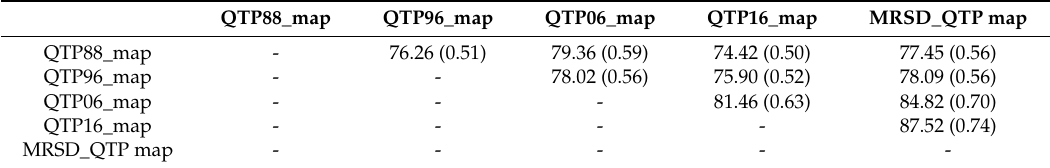
Table 5. Spatial similarity metrics about different frozen soil maps over the QTP. Values indicate overall accuracy (%) and values within parentheses are the Kappa coefficients.